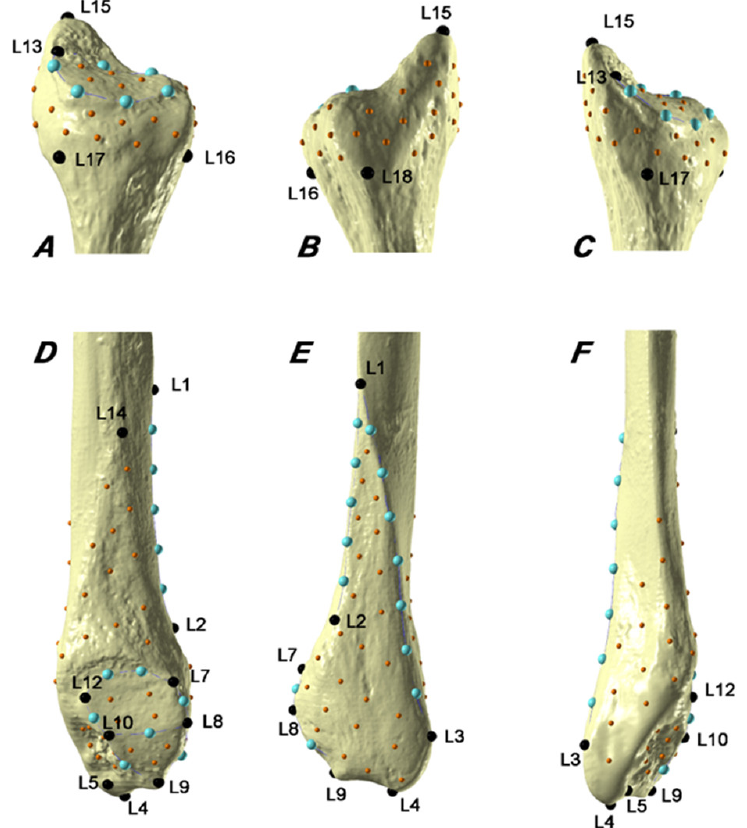
Figure 1. Landmarks (black), curve (light blue), and surface (semi)landmarks (orange) digitized on a left fibula ( A ), proximal fibula, medial view; ( B ), proximal fibula, lateral view; ( C ), proximal fibula, posteromedial view; ( D ), distal fibula, medial view; ( E ), distal fibula, lateral view; ( F ), distal fibula, posterior view. See Table 2 for a detailed description of the anatomical landmarks [37] (license: CC BY 4.0). Table 2. Fibular landmarks and (semi)landmarks identification, definition, and number [37] (license: CC BY 4.0).